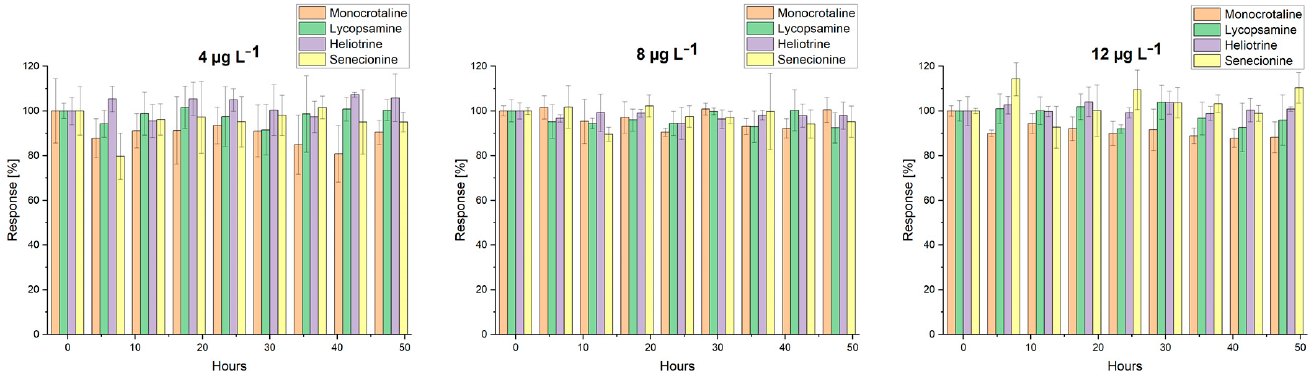
Table 6. Averaged recoveries over six cycles of solid phase extraction using the same HNT-MPTMS- SO 3 H solid material. Figure 6. Autosampler stability of matrix-matched calibration standards with low, medium and high concentrations of pyrrolizidine alkaloids.